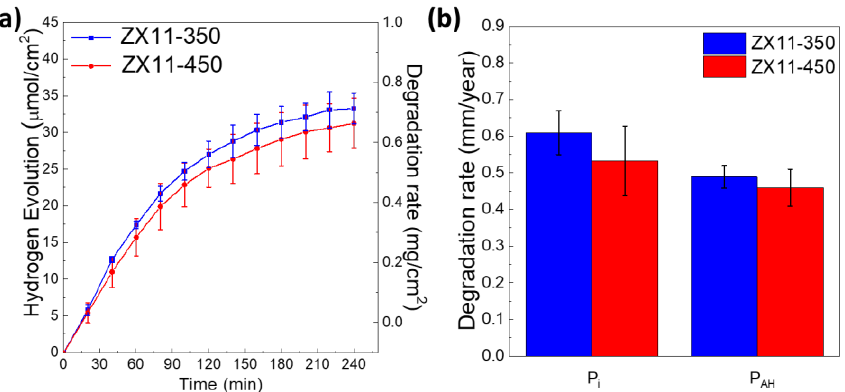
Figure 4. ( a ) Hydrogen evolution of ZX11-350 and ZX11-450 in DMEM/F-12 with 10% v / v FBS. ( b ) Degradation rate calculated from hydrogen evolution and PDP measurements.